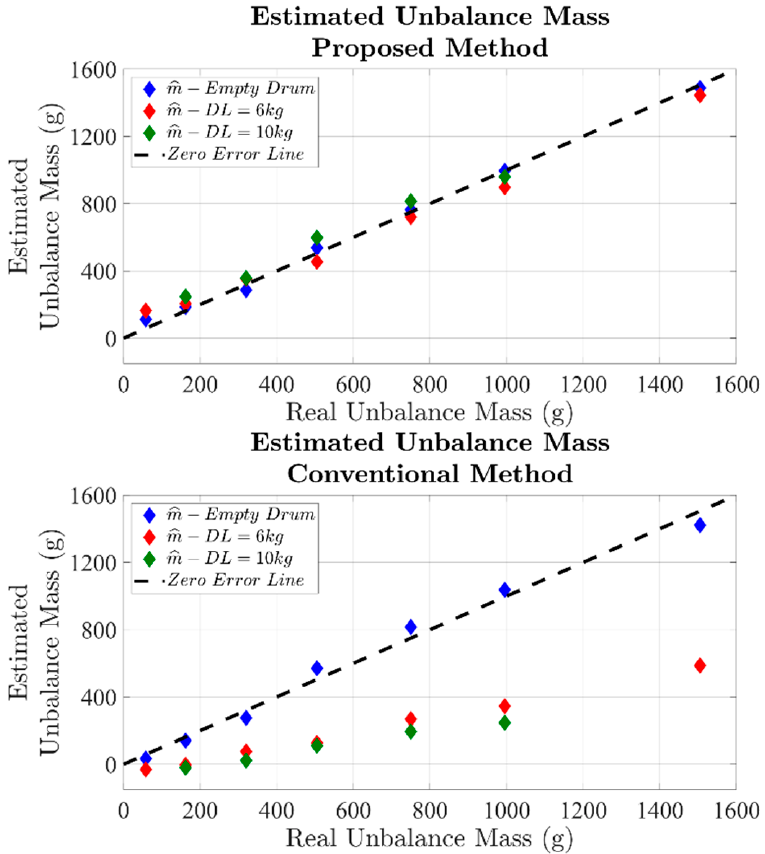
Figure 20. Estimation of the unbalance mass; experimental results obtained with the proposed-( top ) and conventional- ( bottom ) method.